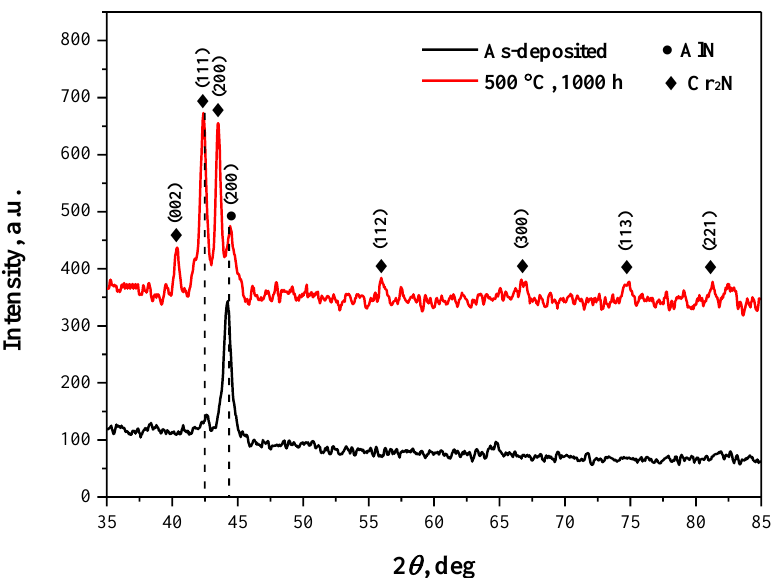
Figure 2. GI-XRD patterns of the coatings before and after annealing at 500 °C in ambient air for 1000 h.